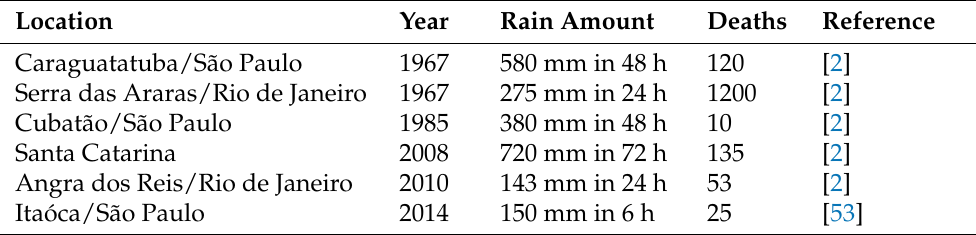
Table 1. High-magnitude landslide events in